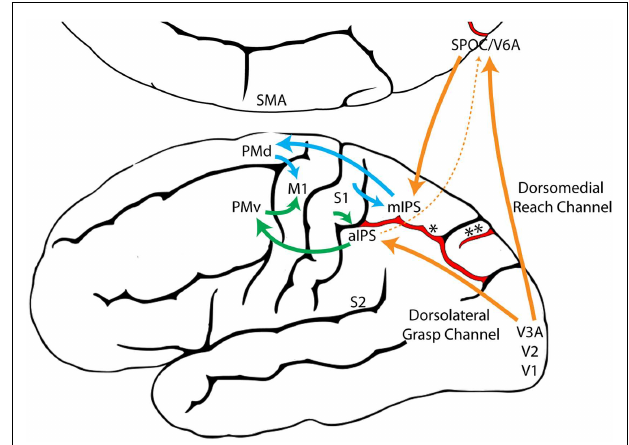
FIGURE 9 |A model illustrating the proposed evolutionary origins for dual visuomotor Reach and Grasp channels in primate parietofrontal cortex .The original dorsomedial stepping/Reach circuit (blue) and the dorsolateral food handling/Grasp circuit (Green) evolved first and were subsequently harnessed by the primate visual system (Orange) through neural re-use (129). (aIPS, anterior intraparietal sulcus; M1, primary motor cortex; mIPS, medial intraparietal sulcus; PMd, dorsal premotor cortex; PMv, ventral premotor cortex; S1, primary somatosensory cortex; S2, secondary somatosensory cortex; SMA, supplementary motor area; SPOC, Superior parieto-occipital cortex;V1, primary visual cortex;V2, secondary visual cortex;V3A, visual area 3A;V6A, visual area 6A, *, intraparietal sulcus, **, parieto-occipital